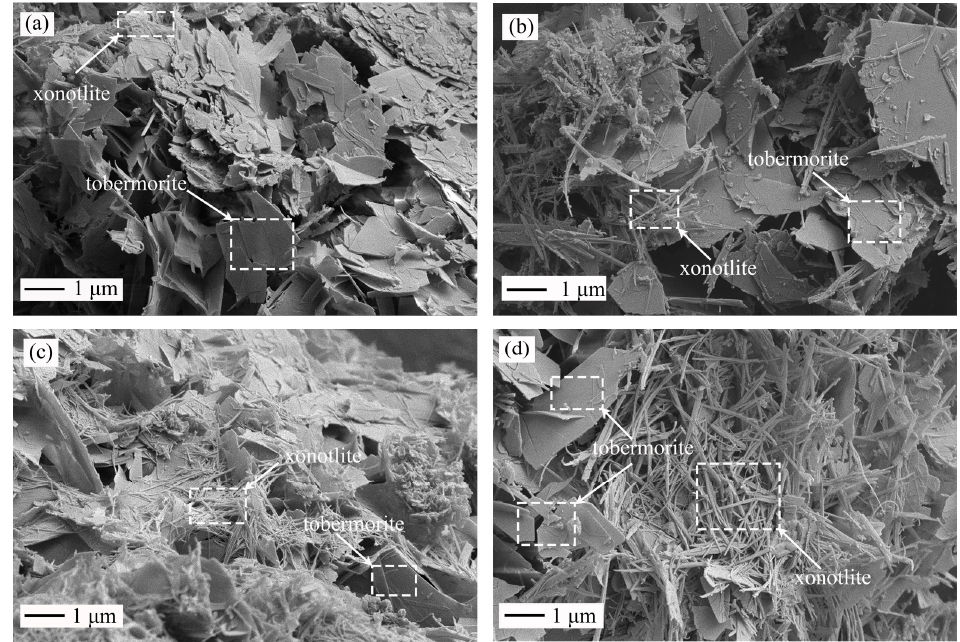
Figure 7. SEM images of the products were synthesized from hydrated cement (M0) and calcined hydrated cement (M900) at 220 °C. Note: ( a ) M0-4 h, ( b ) M900-4 h, ( c ) M0-8 h, and ( d ) M900-8 h.